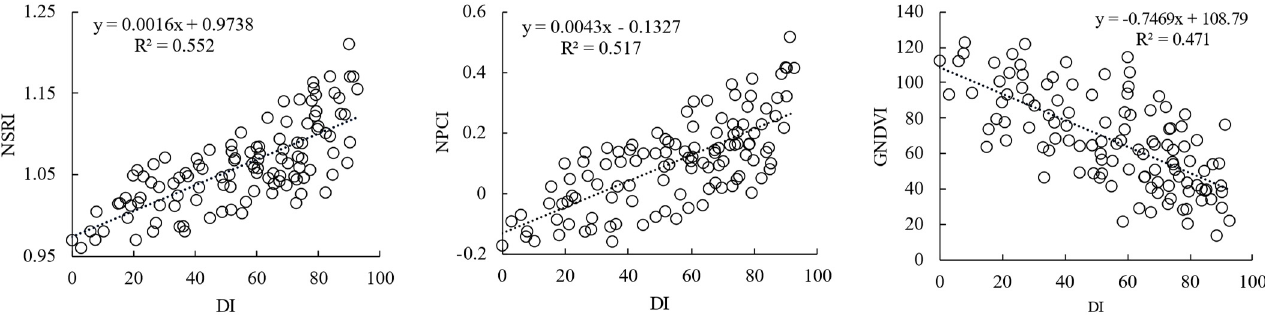
Figure 6. Linear relationship of the optimal vegetation indices with wheat disease index (DI).